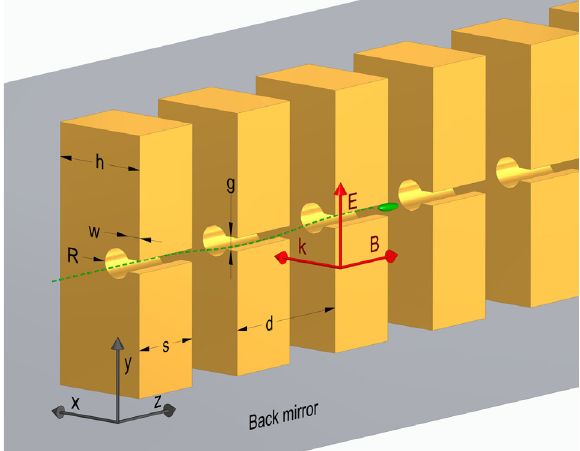
FIG. 1. Schematic of the THz-driven undulator: The electric field of the TDP (shown by red arrows) is enhanced inside the gap of the C-shaped SRRs. An electron bunch (green) propagating in positive z -direction, as indicated by the green dashed curve, is periodically deflected in (cid:2) y -direction and as a result emits linearly polarized radiation.